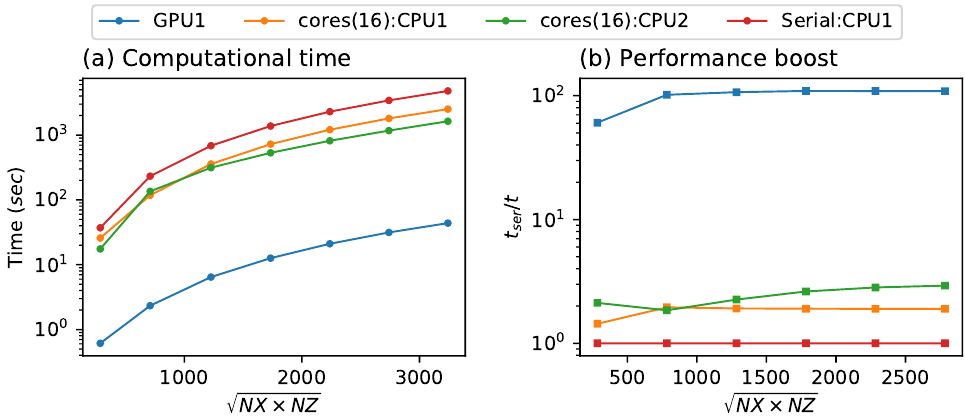
Figure 20. Comparison of computational time and performance for variation of spatial grid NX × NZ keeping temporal grid size constant ( NT = 1000) in forward